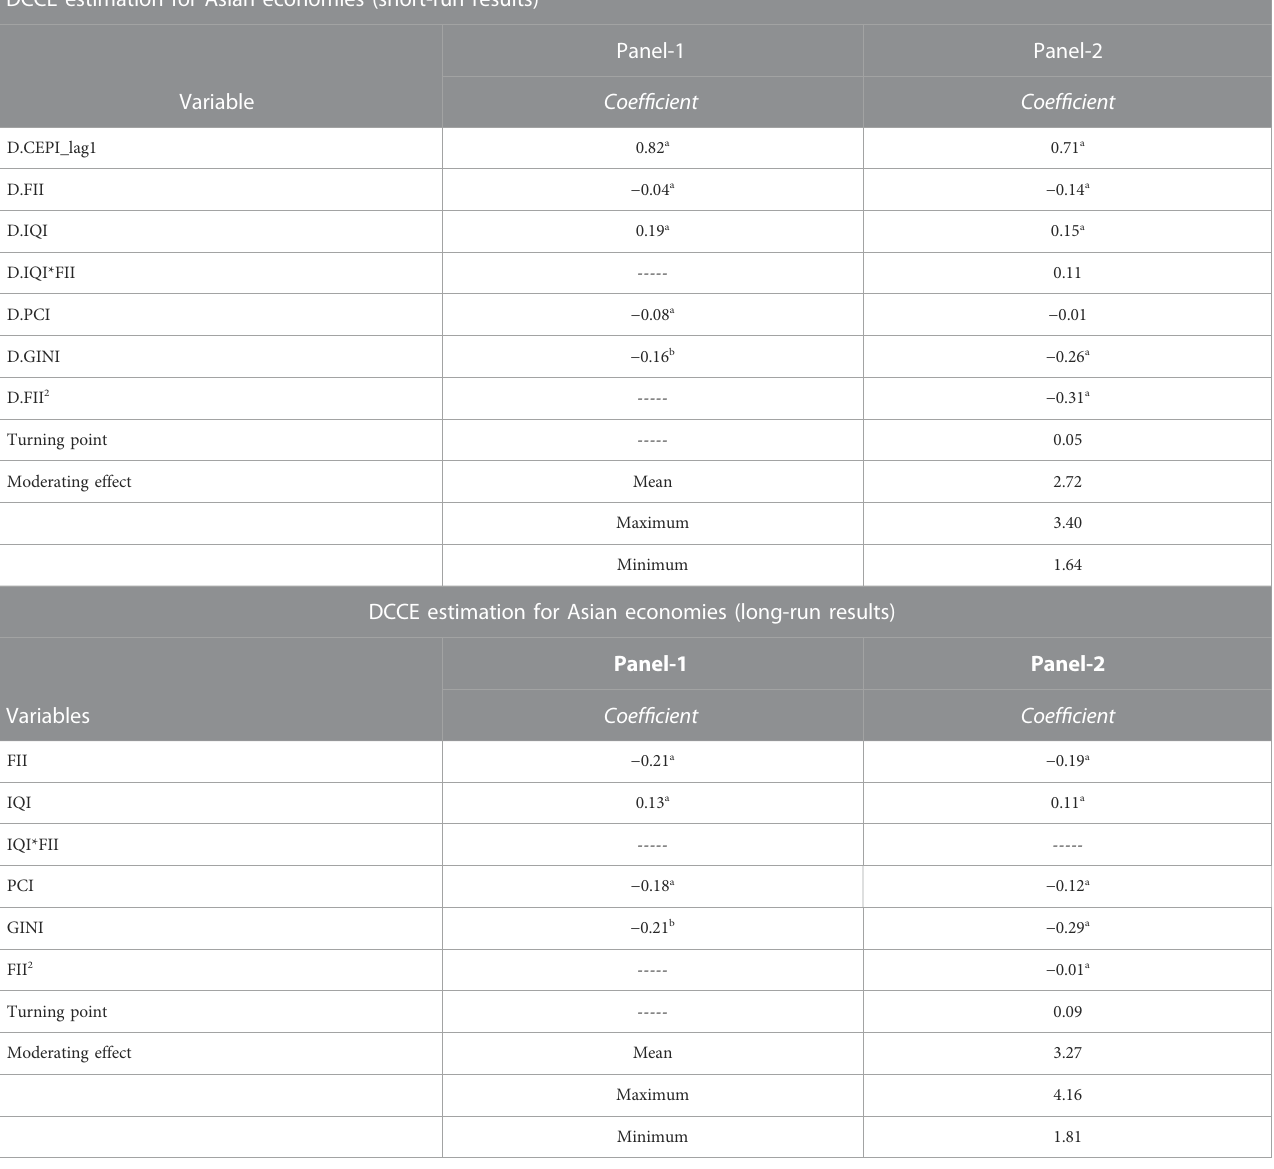
TABLE 4 DCCE estimation for Asian economies. DCCE estimation for Asian economies (short-run